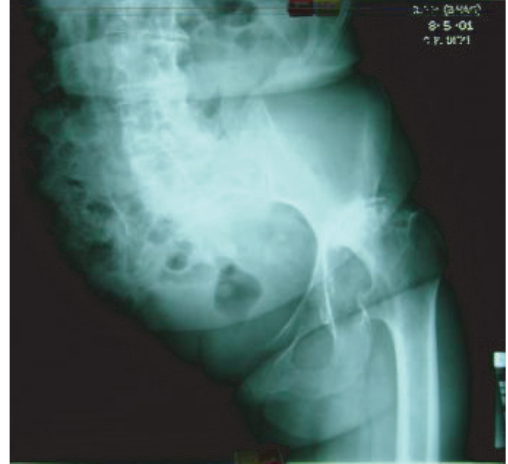
Figure 2: AP X-ray of the pelvis showing the result 9 years follow- ing hindquarter amputation, the marked degenerative changes of the spine, and the severe osteoarthritis changes of the left hip. It is apparent that the whole pelvis is tilted to the left.